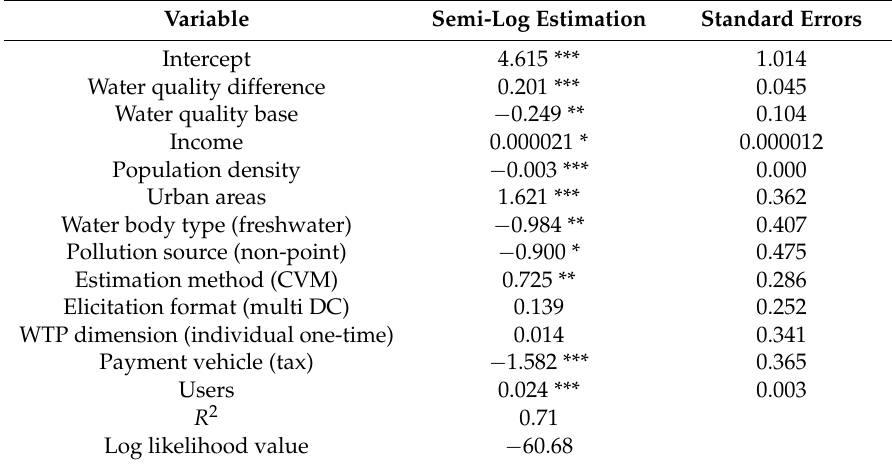
Table 3. Estimated